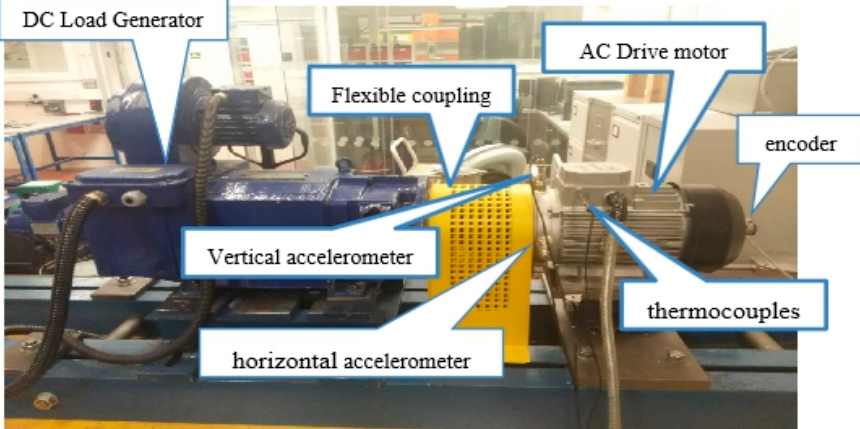
Figure 4. Experimental platform of the induction motor system.